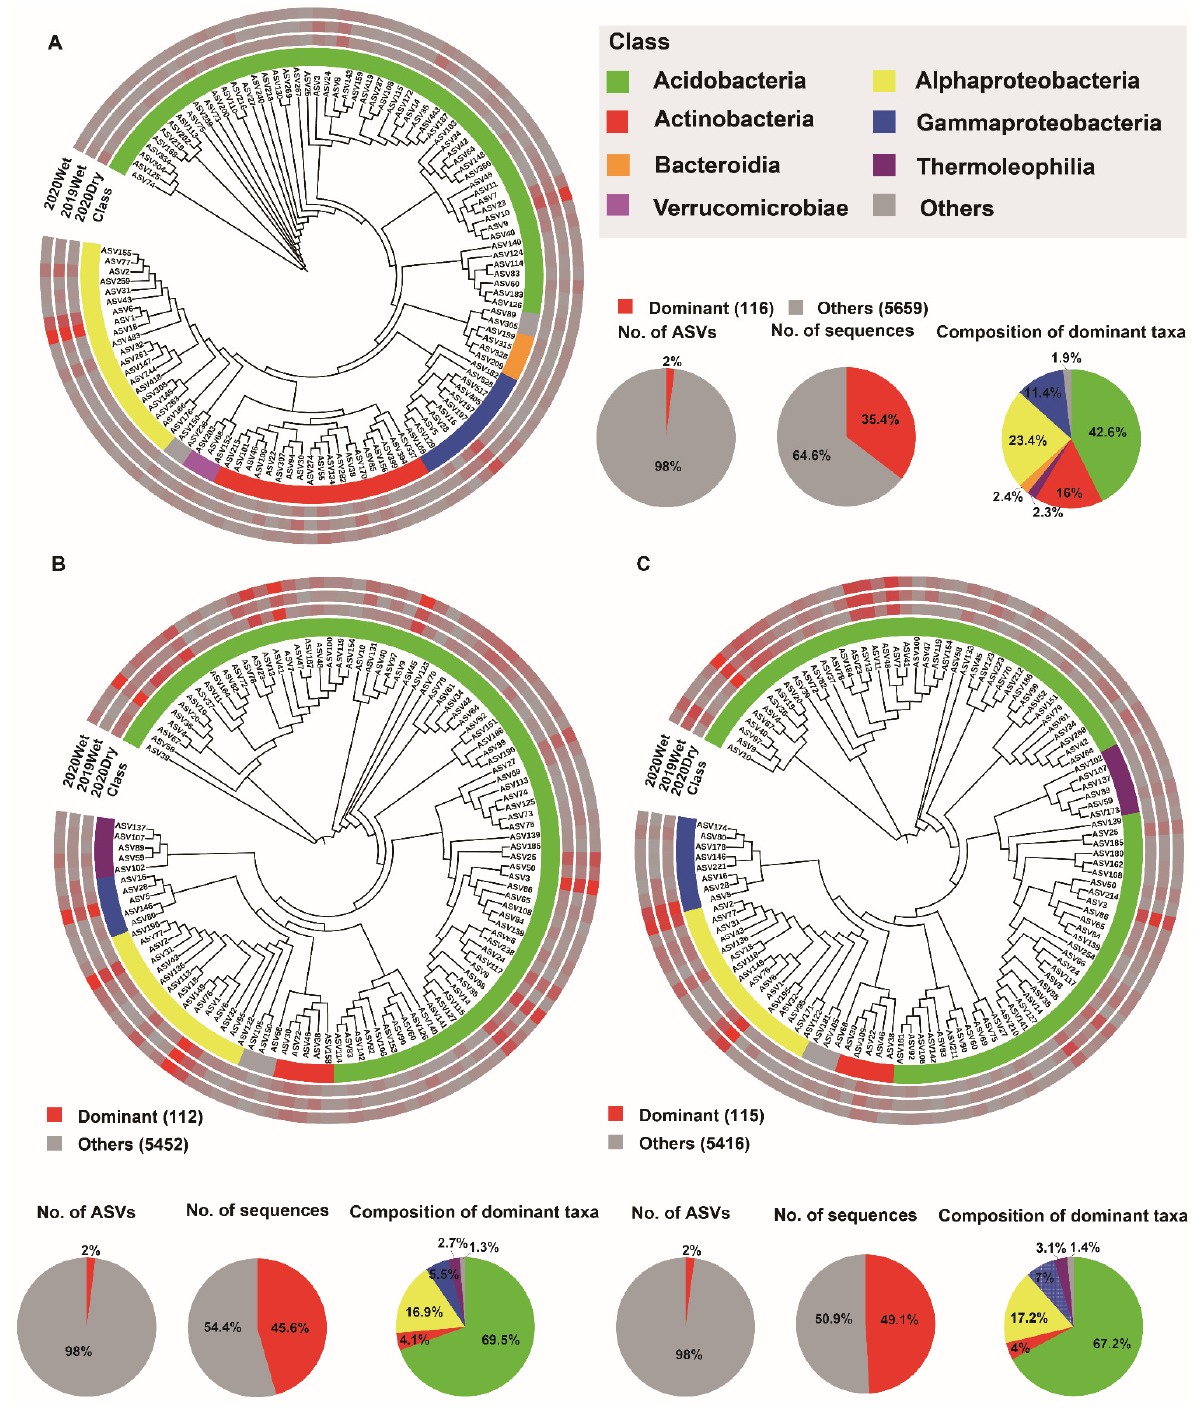
Figure 4. Phylogenetic tree, taxonomic composition, and distribution patterns of soil layer bacterial microbiome dominant taxa. ( A ) Identification of dominant taxa in HF (n = 72). ( B ) Identification of dominant taxa in OS (n = 72). ( C ) Identification of dominant taxa in OM (n = 72). The dominant taxa were defined as ASVs present in more than 80% of all samples and with an average relative abundance ≥ 0.2%. Low abundance classes with <2% of the total sequences of dominant taxa across soil layer are grouped into ‘Others’ . HF: humic fragmented litter, OS: organic soil, OM: organic mineral soil. ASVs: amplicon sequence variants. 2019Wet: samples collected from wet season in 2019;